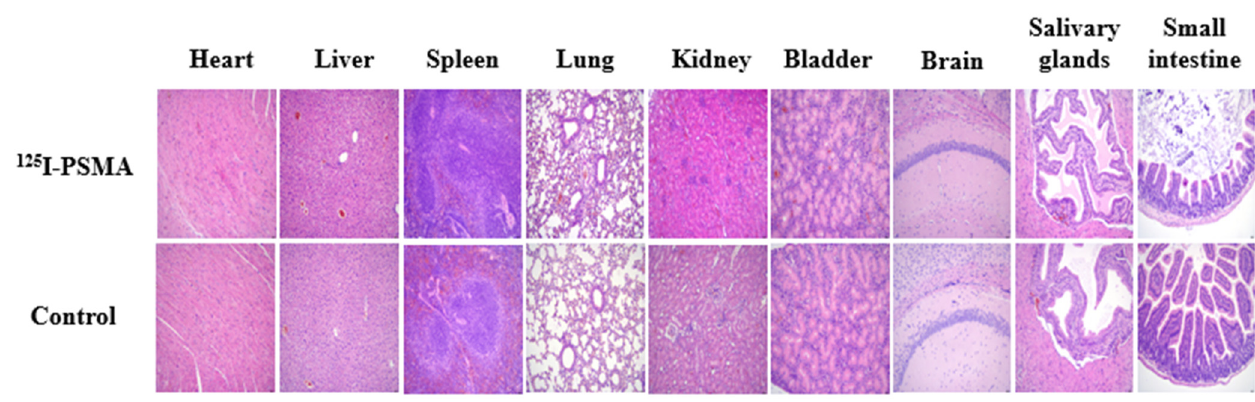
Figure 6. The in vitro stability of 125 I-PSMA-7 in 5% BSA and PBS solutions.